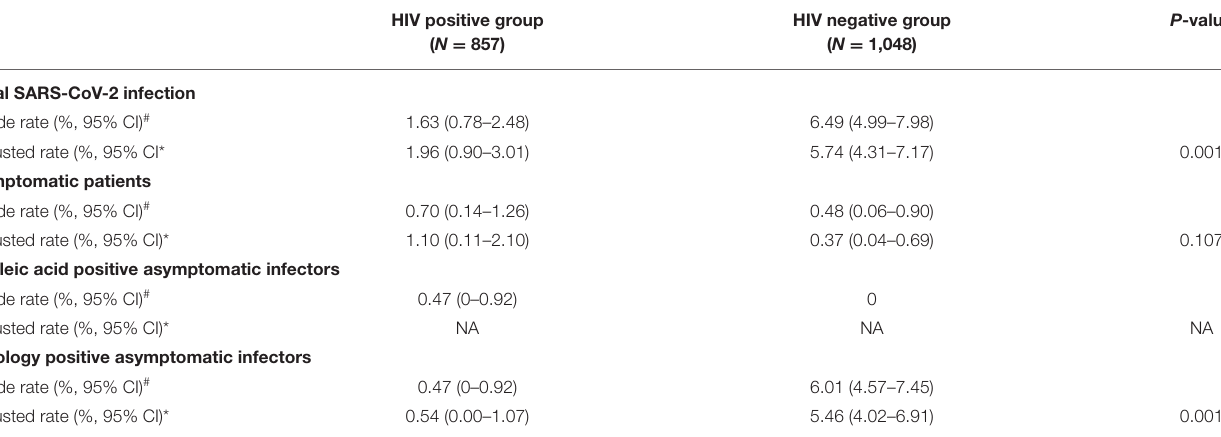
TABLE 2 | Comparison of SARS-CoV-2 infection between HIV positive and negative group in Wuchang District ( N =